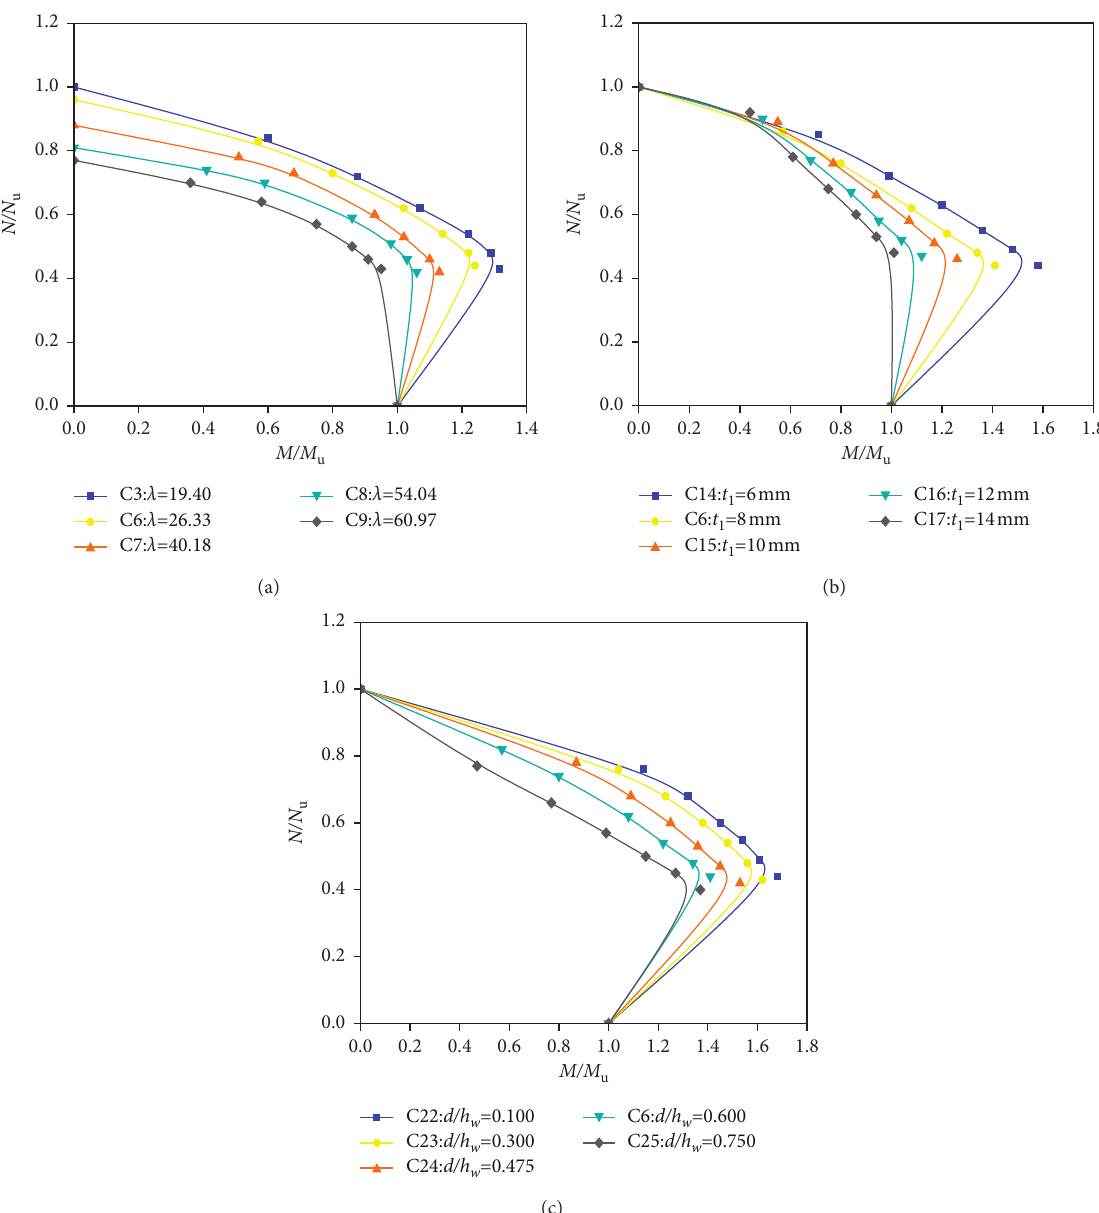
Figure 10: Comparisons of N / N u - M / M u curves of STHCCs with different parameters. (a) λ . (b) t 1 . (c) d / h w